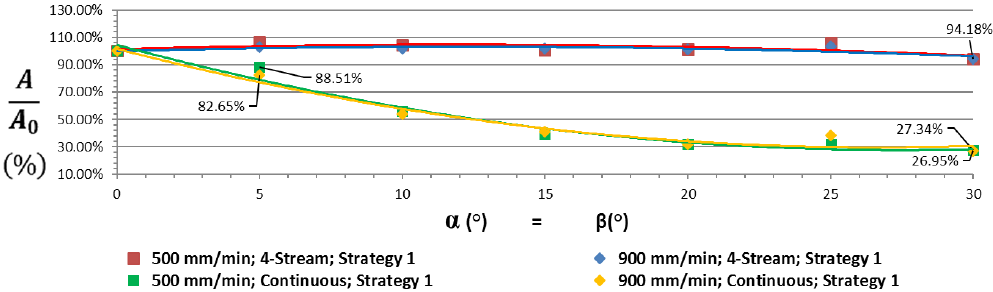
Figure 11. Evolution of the clad area in relation to α and β at 500 and 900 mm · min − 1